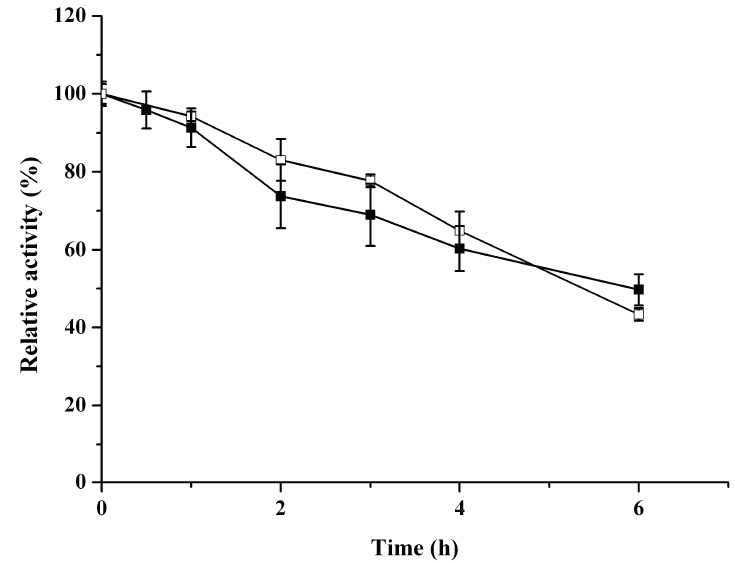
Figure 4. Thermostability of ReBDH. The relative activity of 100% in the alcohol oxidation represents 5.7 U/mg for the oxidation of 2,3-butanediol at 45 °C and pH 10.0. The relative activity of 100% in the ketone reduction represents 11.1 U/mg for acetoin reduction at 55 °C and pH 6.5. Solid symbols, ketone reduction; empty symbols, alcohol